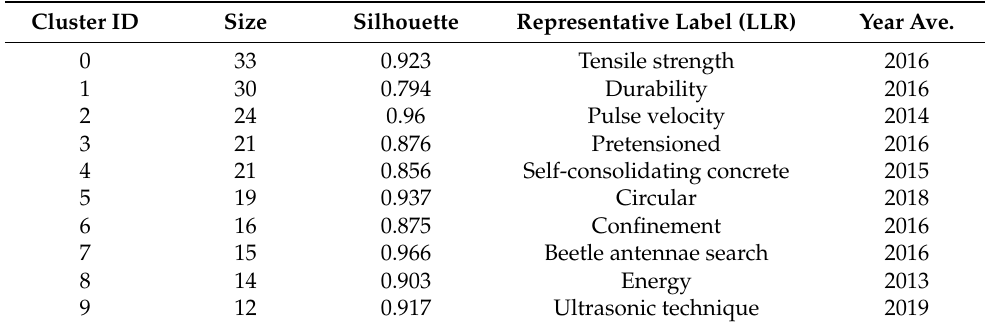
Figure 7. Co-occurrence network map of hot research areas. Table 2. Hot keyword clustering and tagged word information.